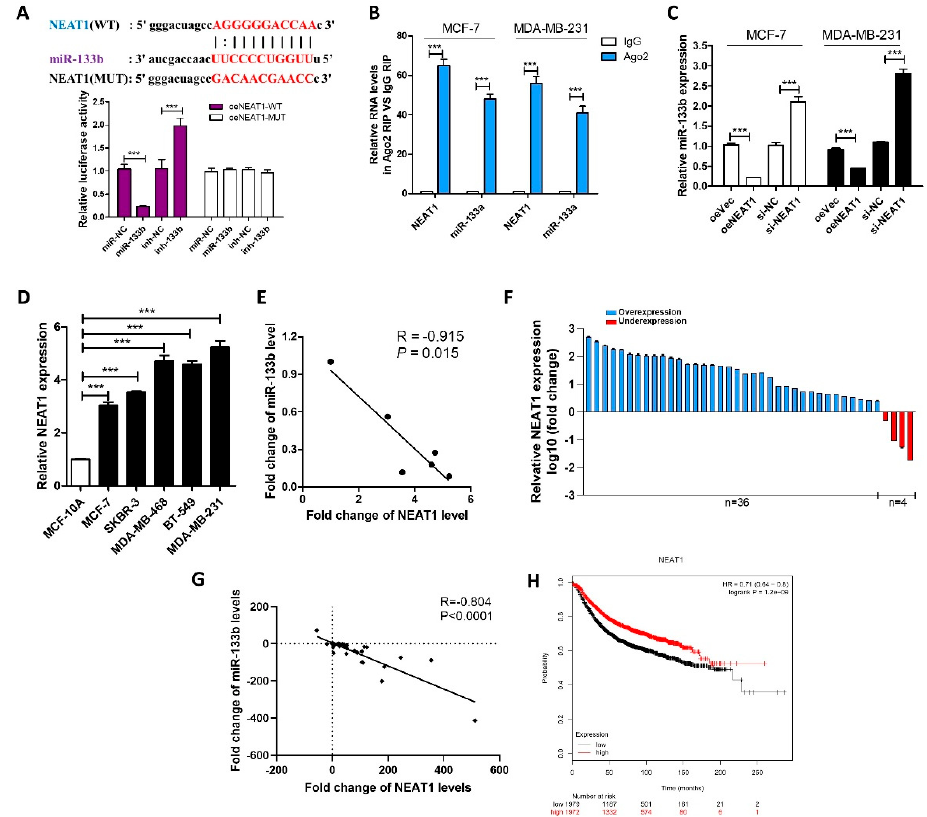
Figure 2. NEAT1 silences mir-133b expression in breast cancer cells. ( A ) Luciferase activity in MCF-7 cells co-transfected with a luciferase reporter containing NEAT1-WT or NEAT1-MUT (miR-133b-binding sequence mutated) and miR-133b. ( B ) Relative enrichment of NEAT1 and miR-133b associated with AGO2 in MCF-7 cells and MDA-MB-231 cells detected by anti-AGO2 RIP (non-specific IgG as negative control). ( C ) miR-133b levels in MCF-7 cells and MDA-MB-231 cells transfected with oeVec, oeNEAT1, si-NC or si-NEAT1. ( D , E ) NEAT1 levels ( D ) and Pearson’s correlation scatter plot of the fold change of NEAT1 and miR-133b levels ( E ) in di ff erent breast cancer cells and normal breast cells. ( F ) NEAT1 levels were detected in 40 pairs of human breast cancer tissues and corresponding adjacent normal tissues by qRT-PCR. ( G ) The correlation between miR-133b and NEAT1 in breast cancer tissues by Spearman correlation analysis. ( H ) Overall survival analysis of breast cancer patients based on NEAT1 expression ( n = 3951, log-rank test). Data was analyzed using Kaplan Meier Plotter (www.kmplot.com). *** p <